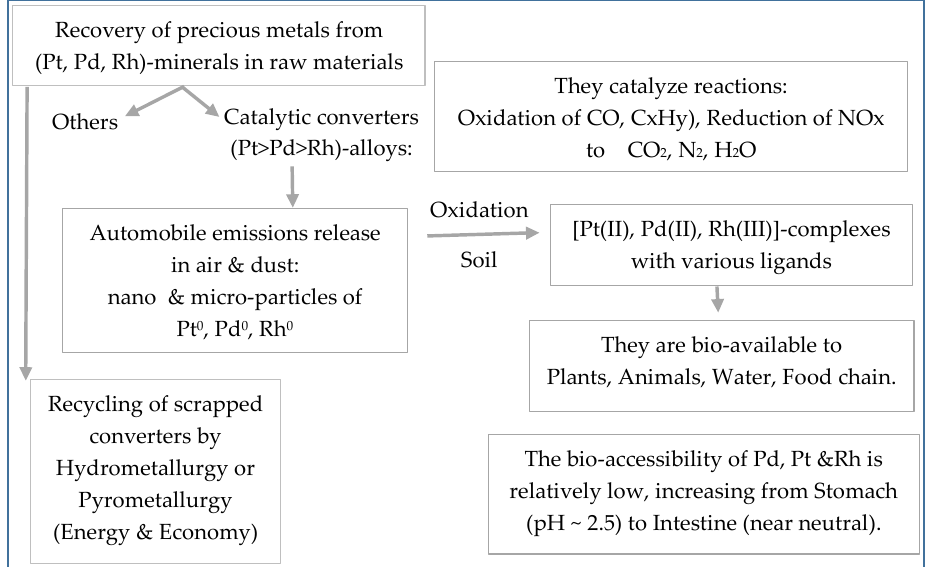
Figure 5. Potential pathways and biogeochemical processes of Pt, Pd, and Rh derived from catalytic converters.